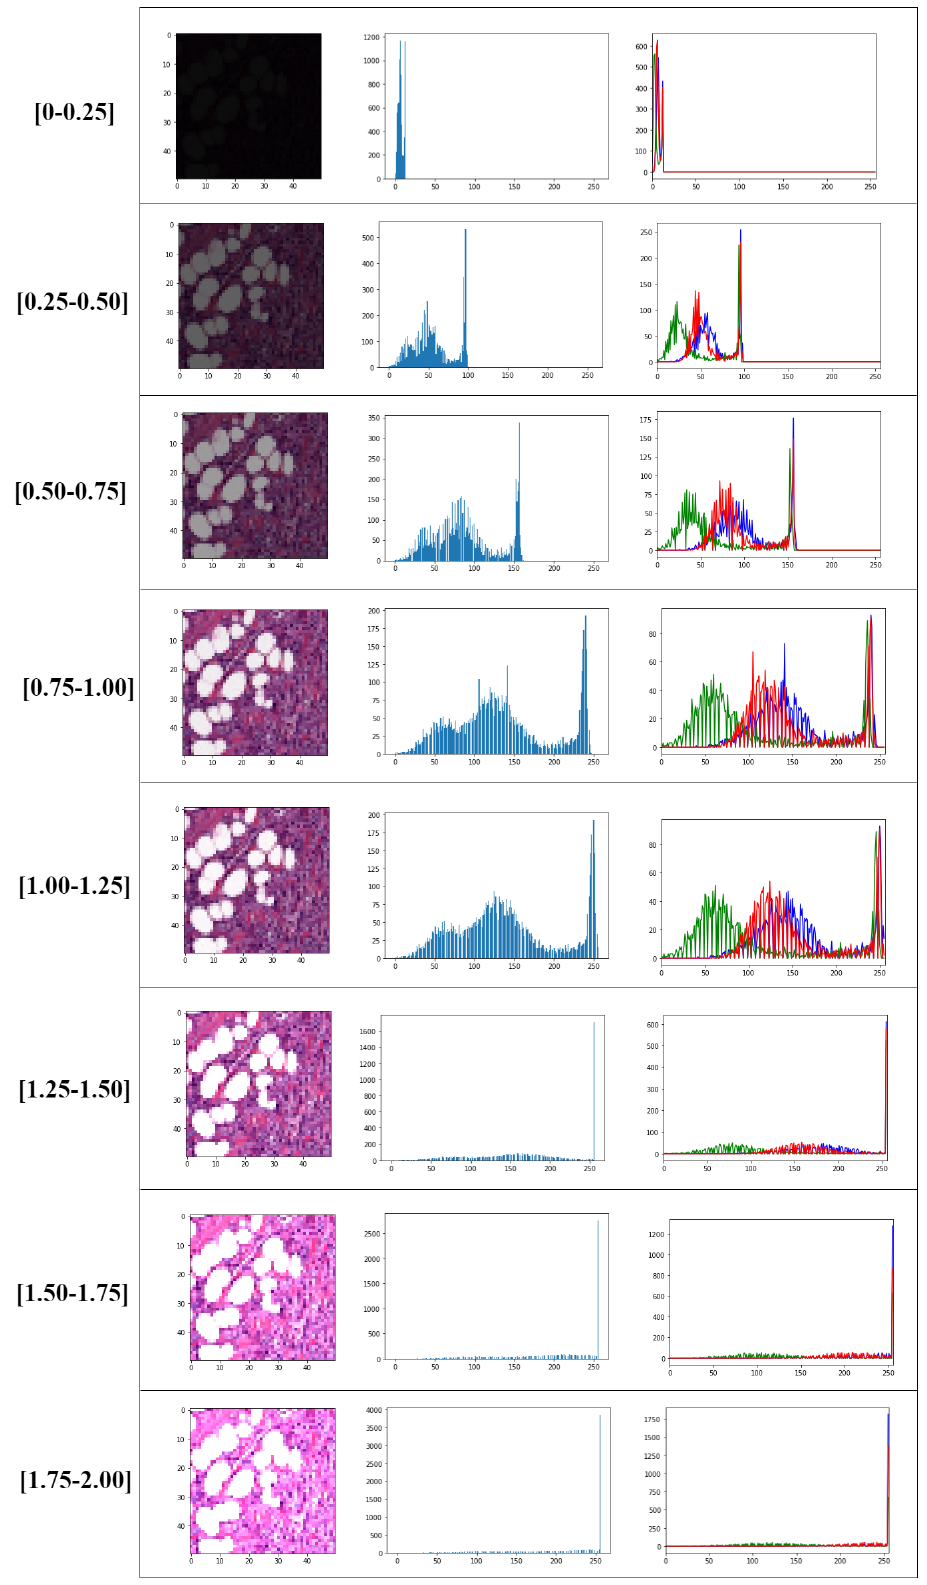
Figure 2. The effect of various brightness augmentations on the image